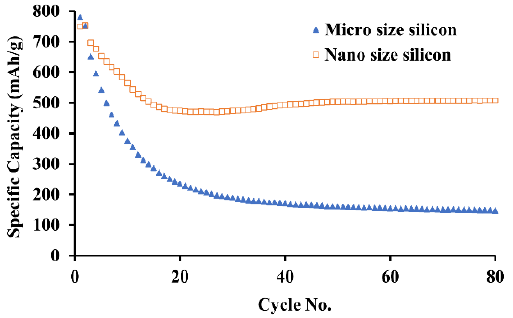
Figure 3. Cycling performance of micro-size and nano-size Si composite anode. Electrode composi- tion: CGP-G8/Si/C45/binder = 73/15/2/10 (wt.%).